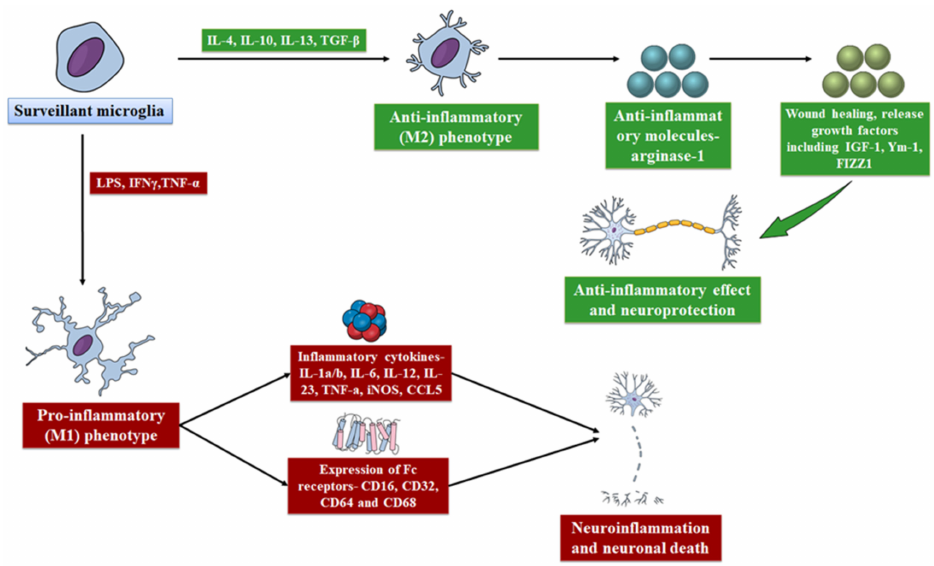
Figure 1. Schematic description of M1 and M2 polarization of microglia and their immunoregulatory